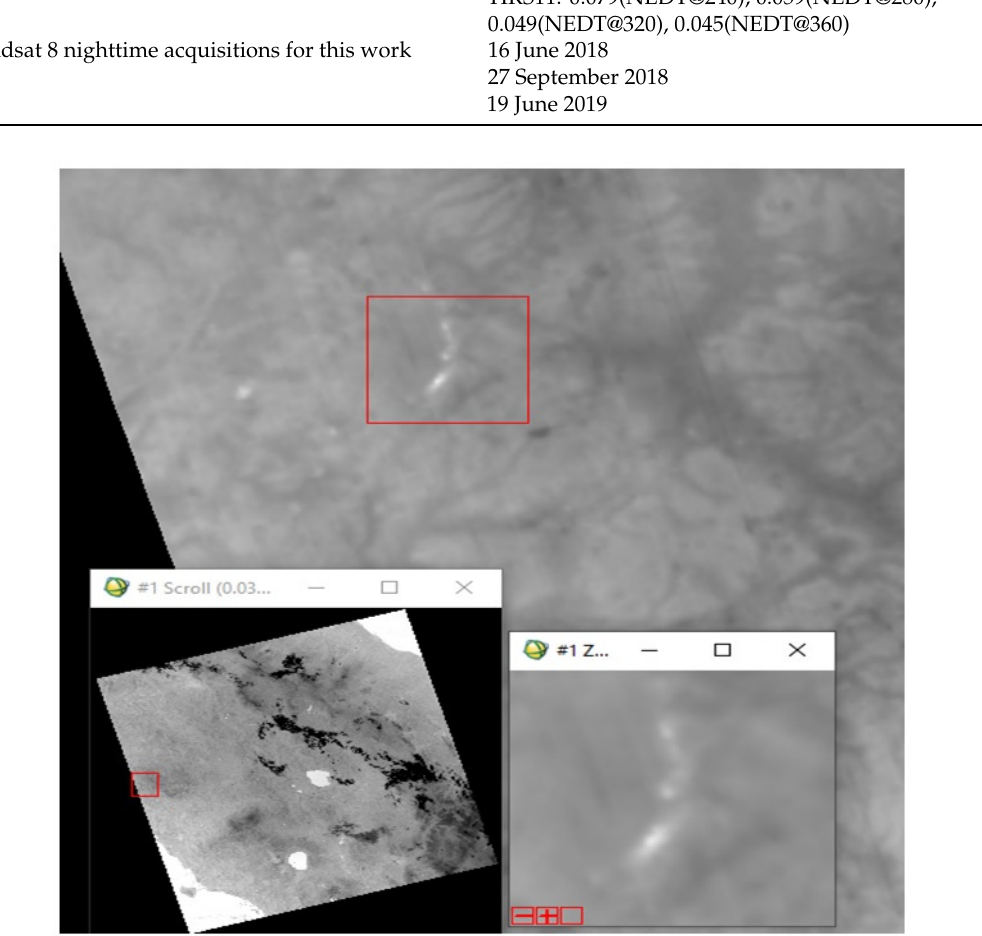
Figure 3. Landsat 8 TIRS 10 band. In the red box the investigated area.